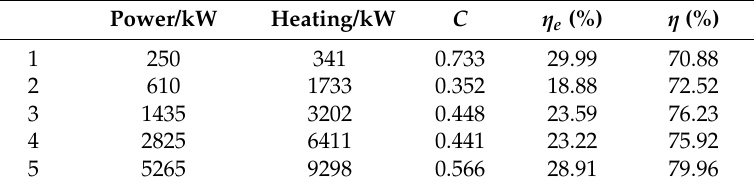
Table 1. Typical technical parameters of representative gas turbine based CHP generation